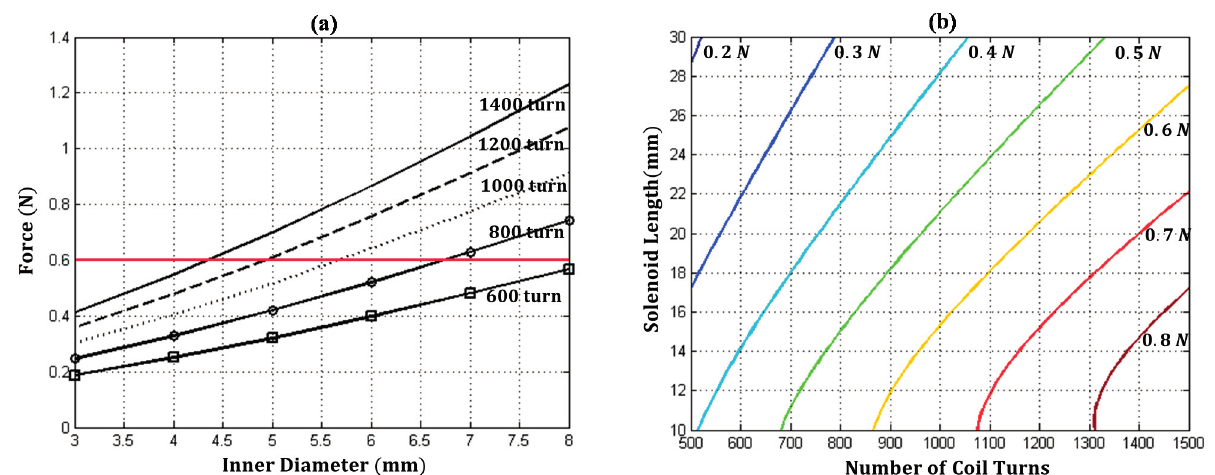
Figure 3. The theoretical analysis of the solenoid force: ( a) the solenoid force for different inner diameters and numbers of coil turns at the solenoid length of 20 mm; ( b ) the distribution of the solenoid force depending on the solenoid length and number of coil turns at the inner diameter of 5